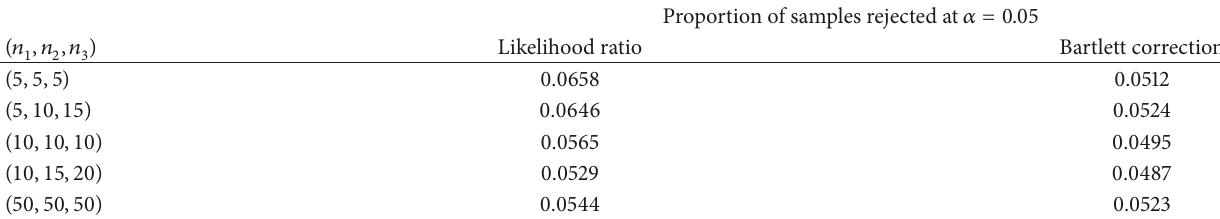
Table 4: The proportion of samples rejected at 5 % level of significance for testing 𝐻 0 : 𝜏 1 = 𝜏 2 = 𝜏 3 = 𝜏 when data are generated from lognormal (0, 1)